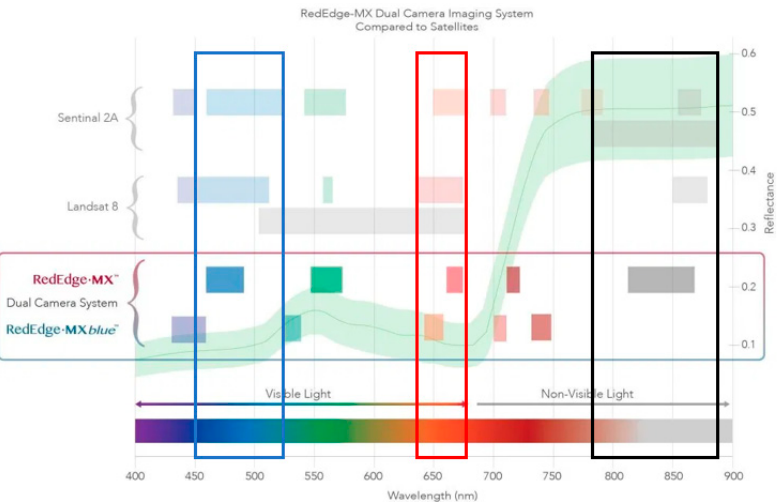
Figure 4. Spectral reflectance band comparison of dual camera system with Landsat 8 and Sentinel-2 (used with permission from MicaSense, Inc., Seattle, WA, USA). Colored boxes represent blue, red, and NIR wavelengths for each imaging system.